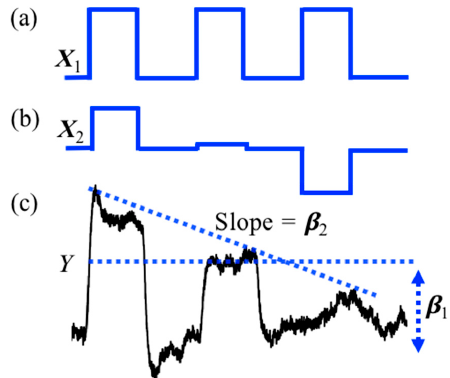
Figure 2. Illustration of the parametric stimulus design: ( a ) Conventional box-car function as the stimulus design; ( b ) parametric stimulus design with time varying models; ( c ) evoked signal from parametric stimulus design in ( b ).